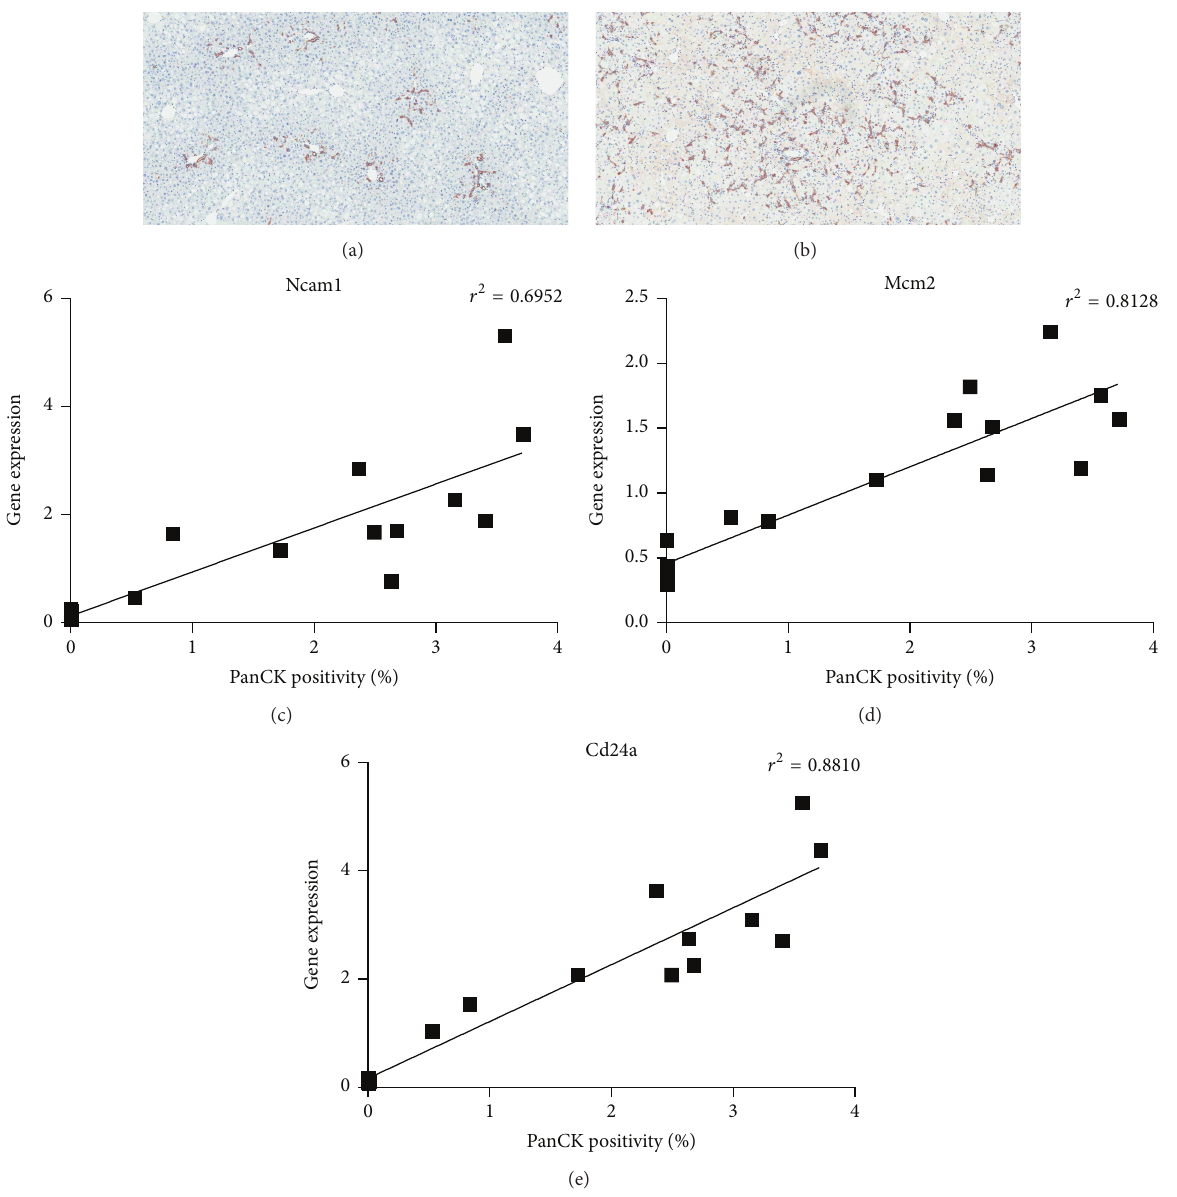
Figure 7: Gene expression of group 𝛽 and 𝛾 genes, Ncam1 and Mcm2 , and the known marker Cd24a correlate with panCK staining in vivo . Representative images of (a) control and (b) choline-deficient, ethionine-supplemented (CDE) mouse liver sections stained for panCK. Expressions of (c) Ncam1 , (d) Mcm2 , and (e) Cd24a relative to Taf4a in a variety of CDE and control liver tissues are plotted against their corresponding panCK positivity